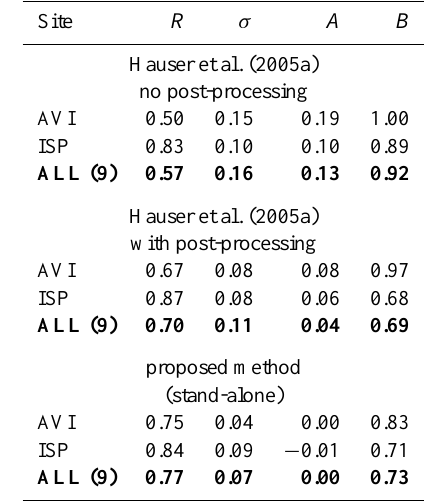
Table 2. Comparison of the original (Hauser et al., 2005a) and the new method to derive τ a from AVHRR over land surfaces. The dif- ferences between the various methods are explained in Sect. 3. R denotes the linear correlation coefficient, σ is the standard devia- tion, A and B are the coefficients of the linear regression equation y = A + Bx